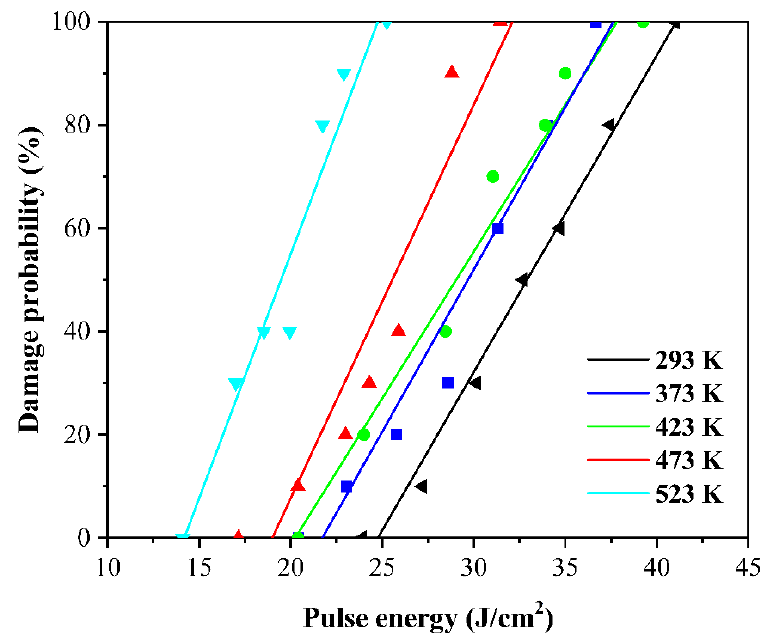
Figure 6. In situ high temperature LIDT results of the films.